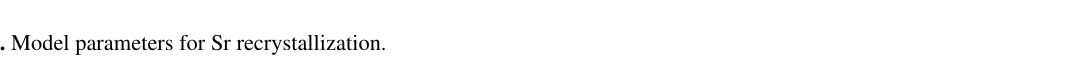
Table E6. Model parameters for Sr recrystallization.